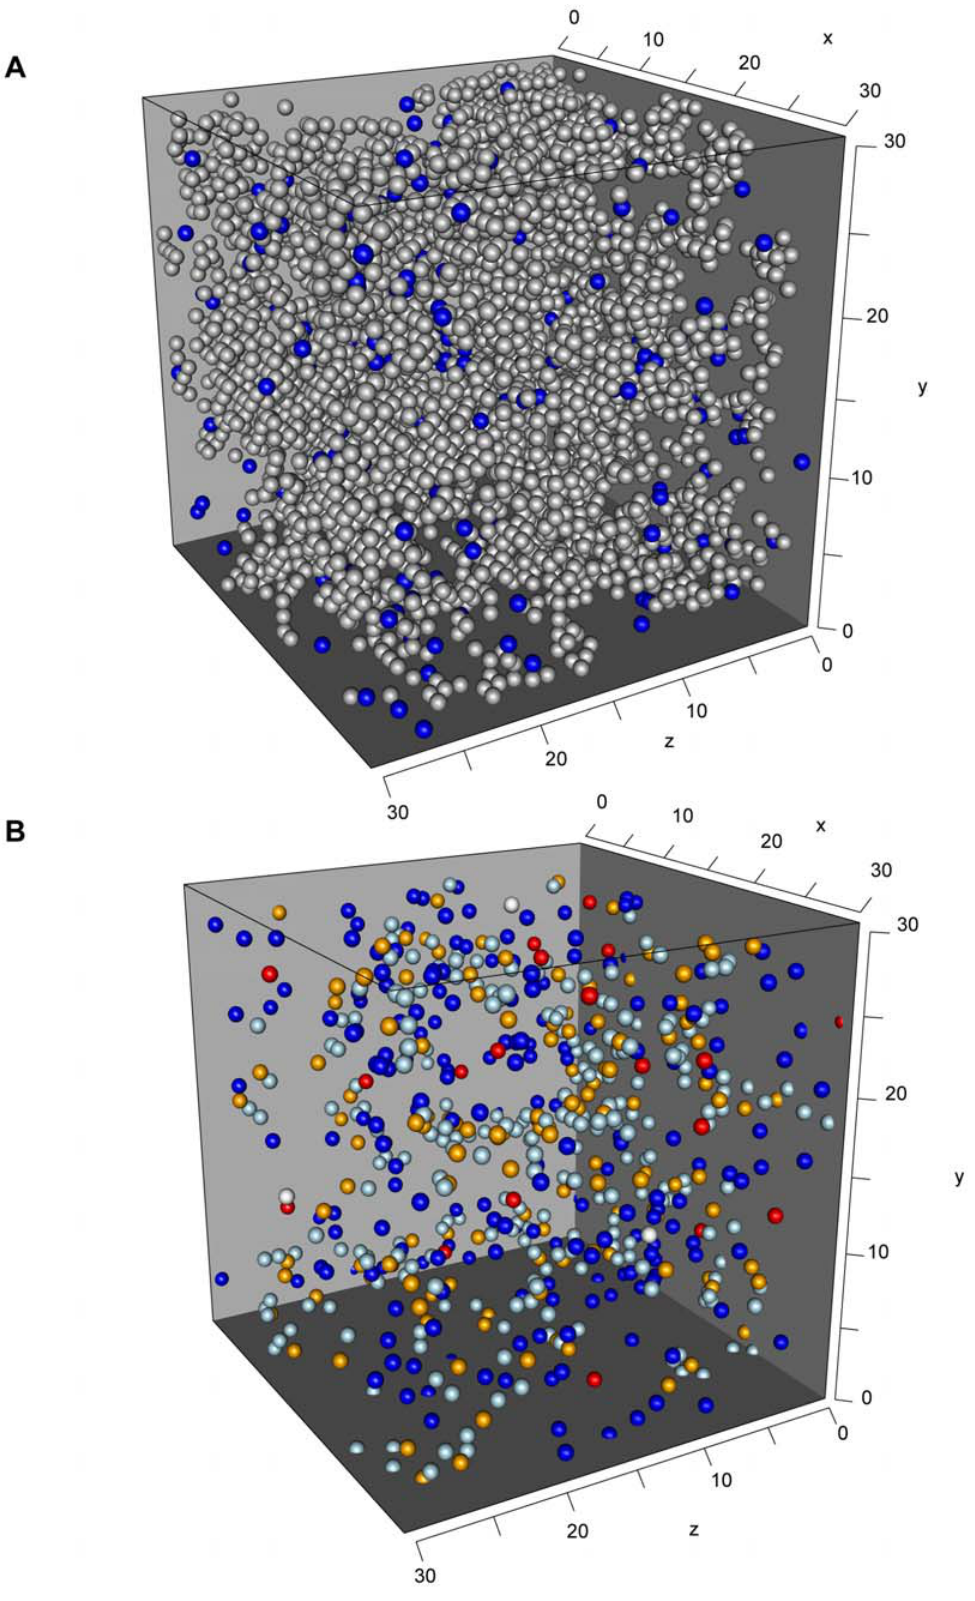
Figure 1. Snapshots of the simulated 3D cellular automaton. (A) CA at the beginning showing CTL (blue) and reticular network (grey). Other cell types are not shown. (B) CA in the middle of a simulation showing target cells (red) and CTL (blue). Target cells in contact to a CTL are labeled in orange, bound CTL in lightblue.